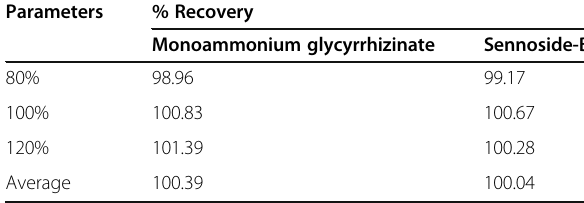
Table 8 Accuracy study of the developed method Parameters